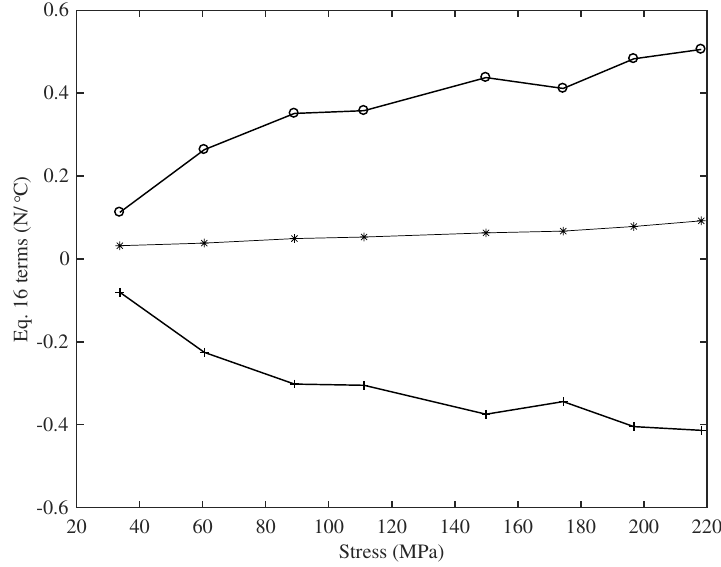
Figure 20. A comparison of the di ff erent terms of Equation (16) for one of the nylon A6 strings (String 8). The lower line ( + ) shows ( F 0 / A 0 E 0 ) d ( AE ) / dT ; the upper line (o) shows − A 0 E 0 α ; and the middle line (*) gives the combined term dF / dT taken from the gradient of the tension versus temperature response of the string held at constant